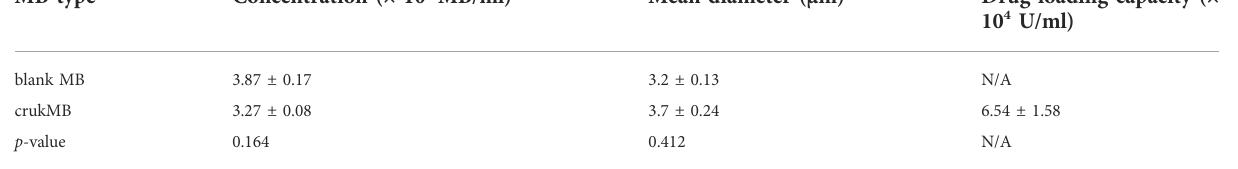
TABLE 2 Characterization of MBs and